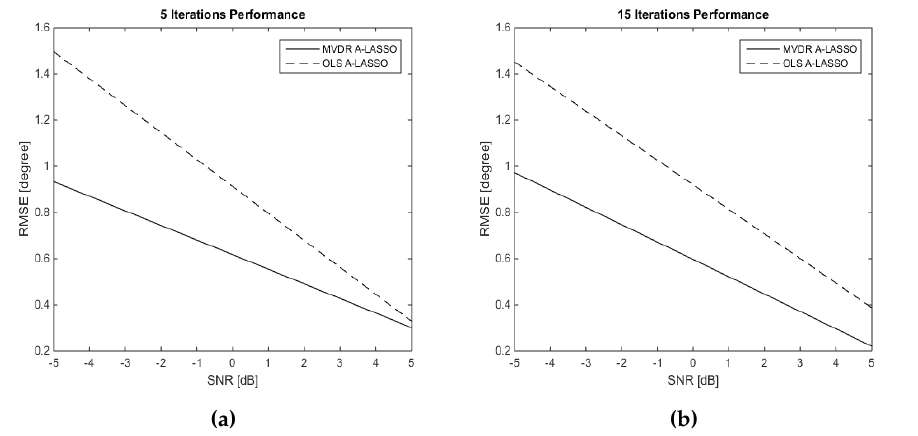
Figure 12. DOA estimation of two source signals at DOAs 60 ◦ and 120 ◦ , and 10 snapshots ( a ) after five iterations and ( b ) after 15 iterations, using the A-LASSO